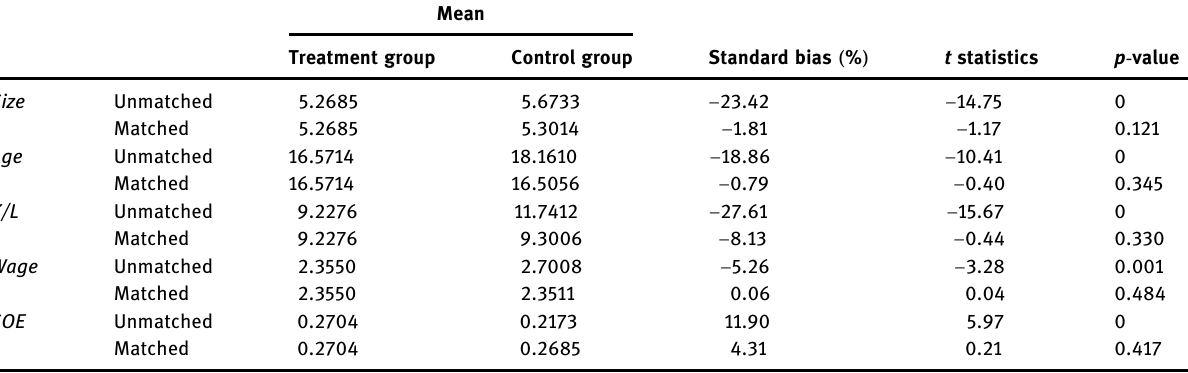
Table 6: Balance test of matching variables